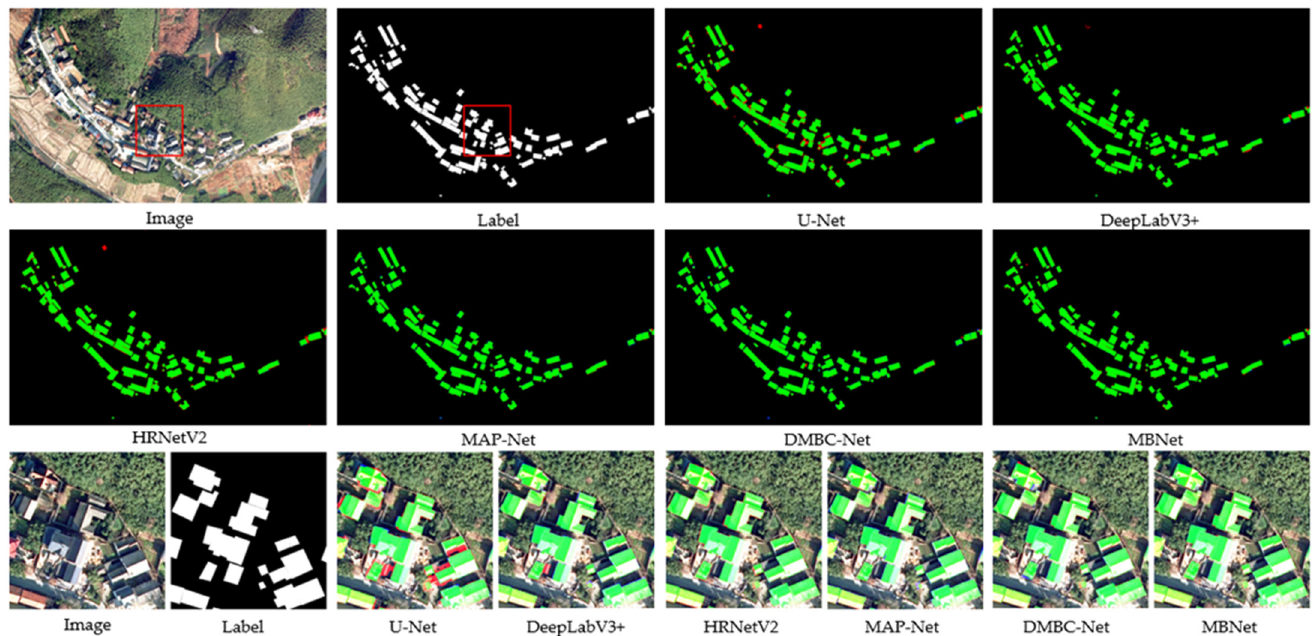
Figure 7. Segmentation results of the different SOTA methods on the mountain landform scene 2 test dataset. The bottom row is a close-up view of the red box.